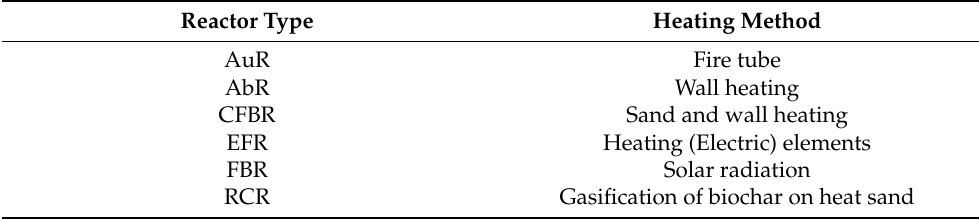
Table 4. The common methods of heating applicable to different types of reactors